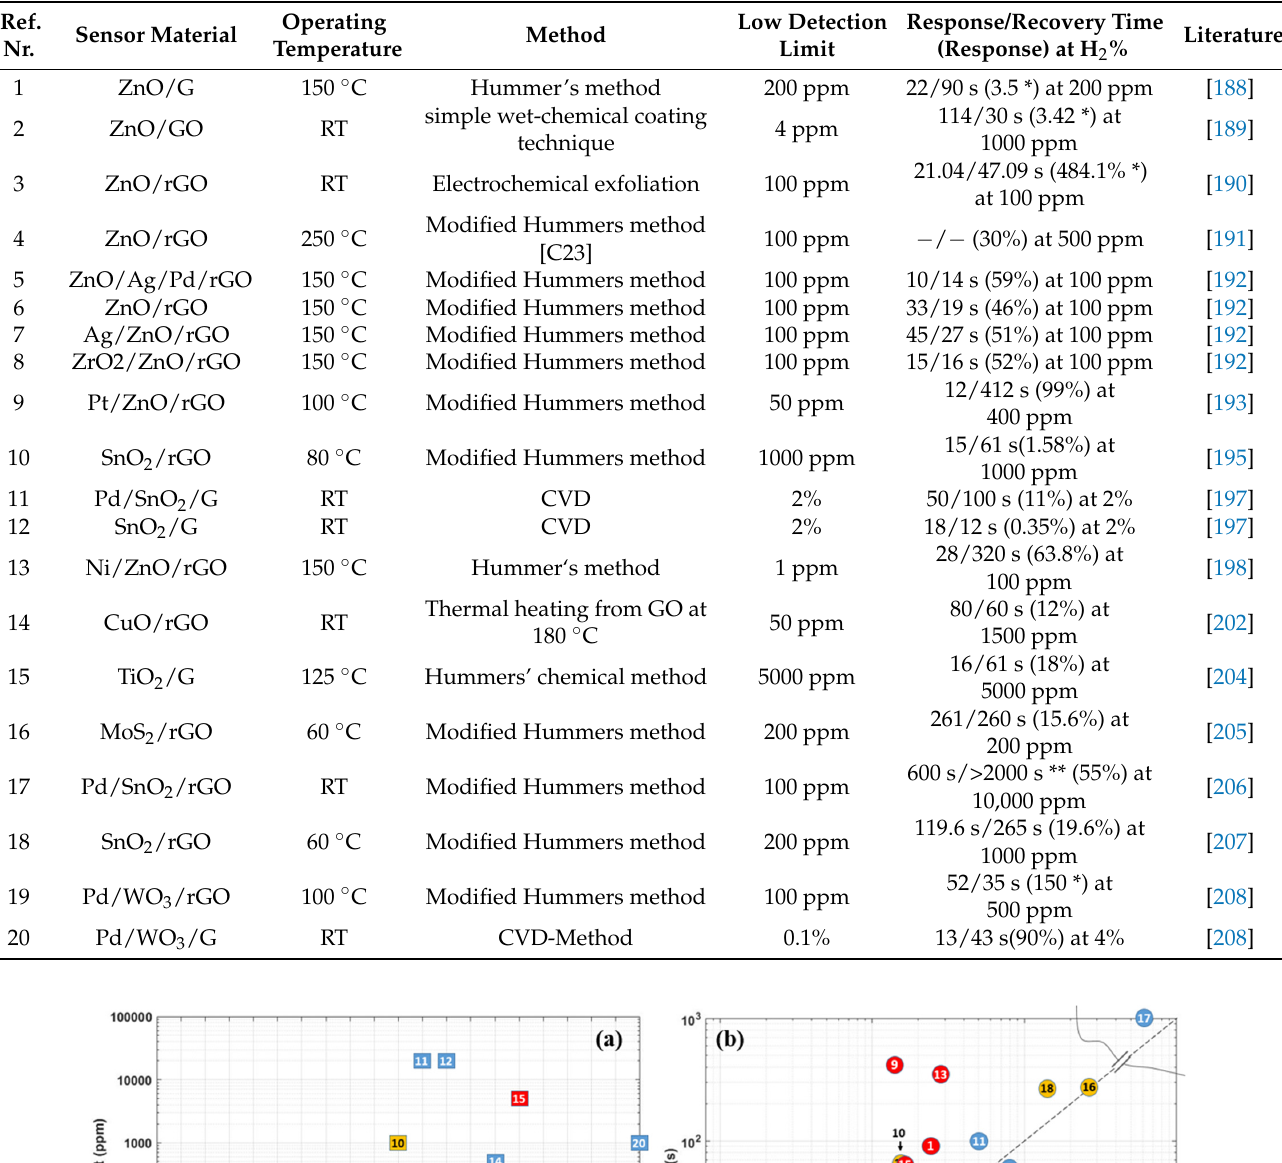
Table 4. Comparison of sensing performances towards hydrogen gas of metal oxide semiconductor (MOS)/graphene (e.g., GO, rGO)-based gas sensors in literature. Unless specified, the sensor response is defined by the given Equation (1). (*) Sensor response given by the form R a /R g . (**) The recovery times were not given directly in their publications and were read out approximately from the sensing response curves in the corresponding literature. RT: room temperature, CVD: chemical vapour deposition.